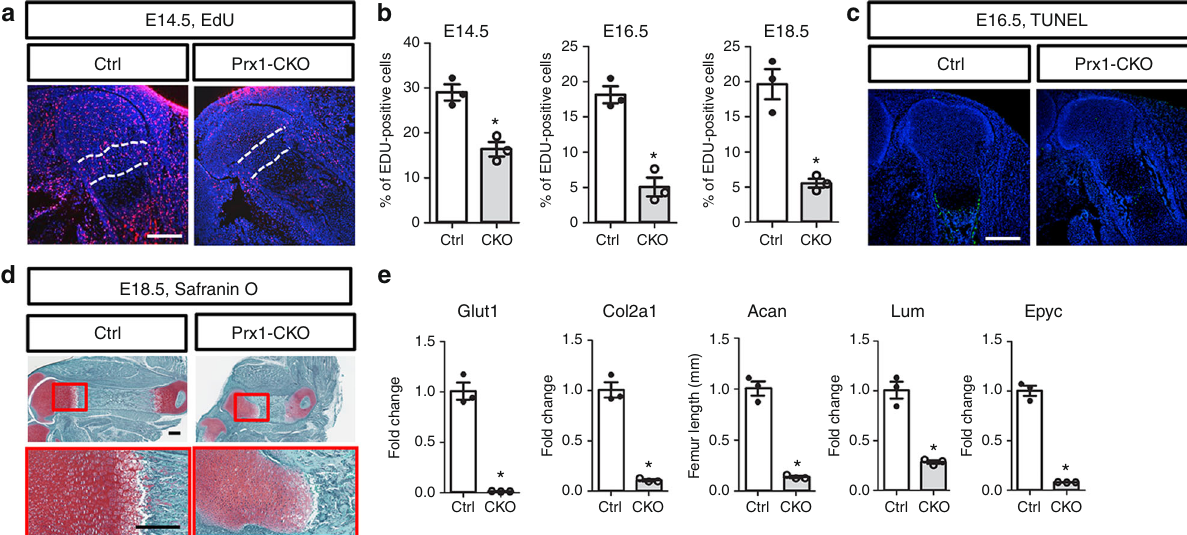
Fig. 4 Glut1 is necessary for chondrocyte proliferation and matrix production. a Representative images of EdU labeling (red) in the femur at E16.5. Region between dashed lines is used for quanti fi cation of labeling index. b EdU quanti fi cation. * p < 0.05, n = 3 mice, error bar indicates SD, two-tailed Student ’ s t - test. Scale bar: 250 µ m. c , d Representative images of TUNEL ( c ) or Safranin O staining ( d ). e Gene expression assayed by RT-qPCR in cartilage. * p < 0.05, n = 3 mice, error bar indicates SD, two-tailed Student ’ s t -test. Scale bar: 250 µ m. Images are representative of three